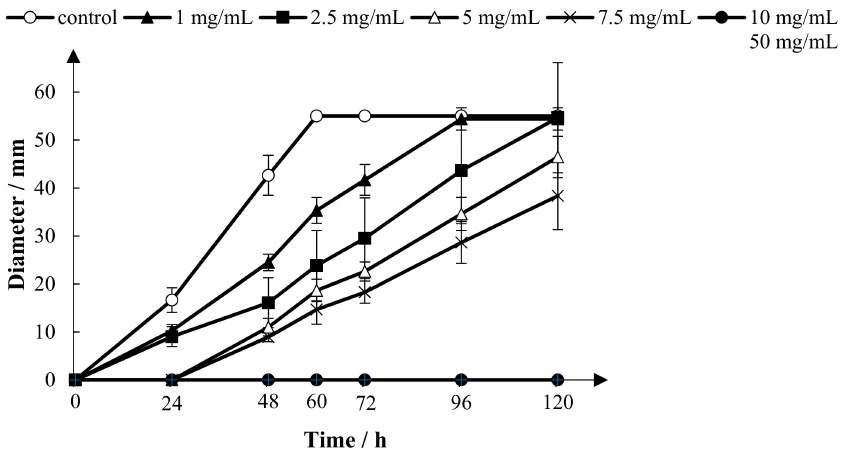
Figure 12. Growth curve of the B. dothidea colony on PDA plates under di ff erent concentrations of garlic extract ( n =